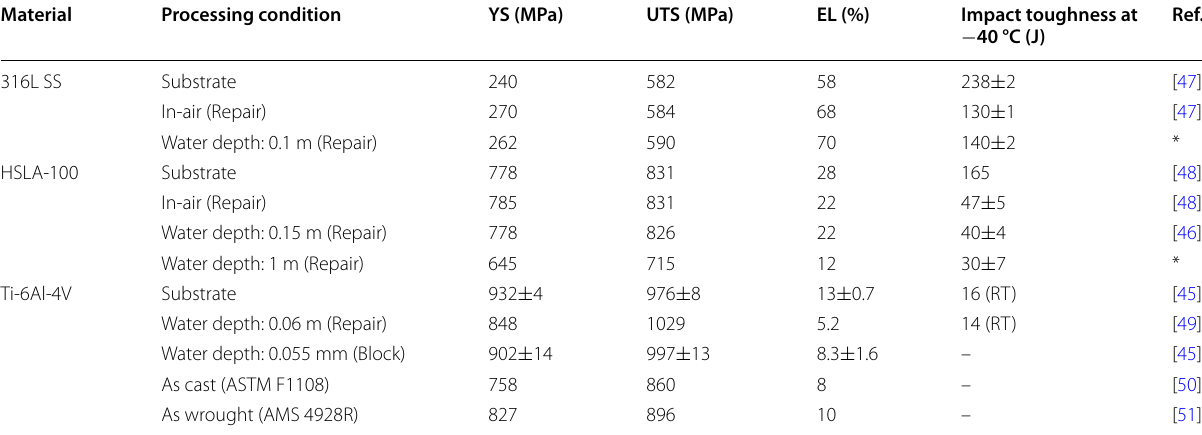
Note: The symbol * represents that the data were obtained by the authors